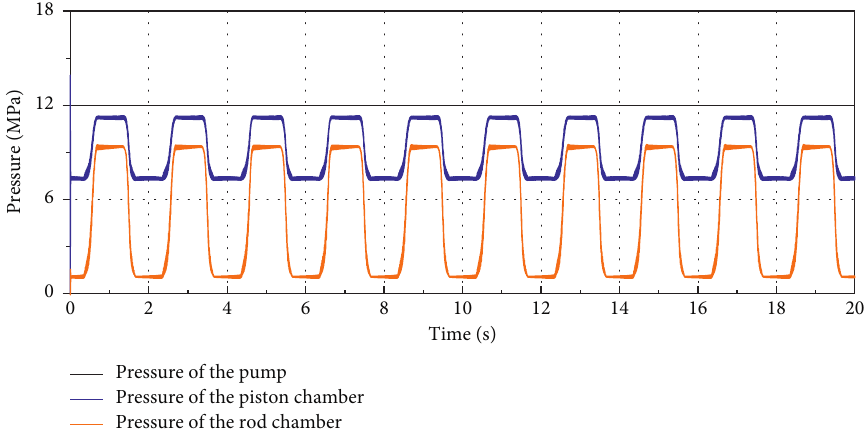
Figure 11: Pressures of system 3.